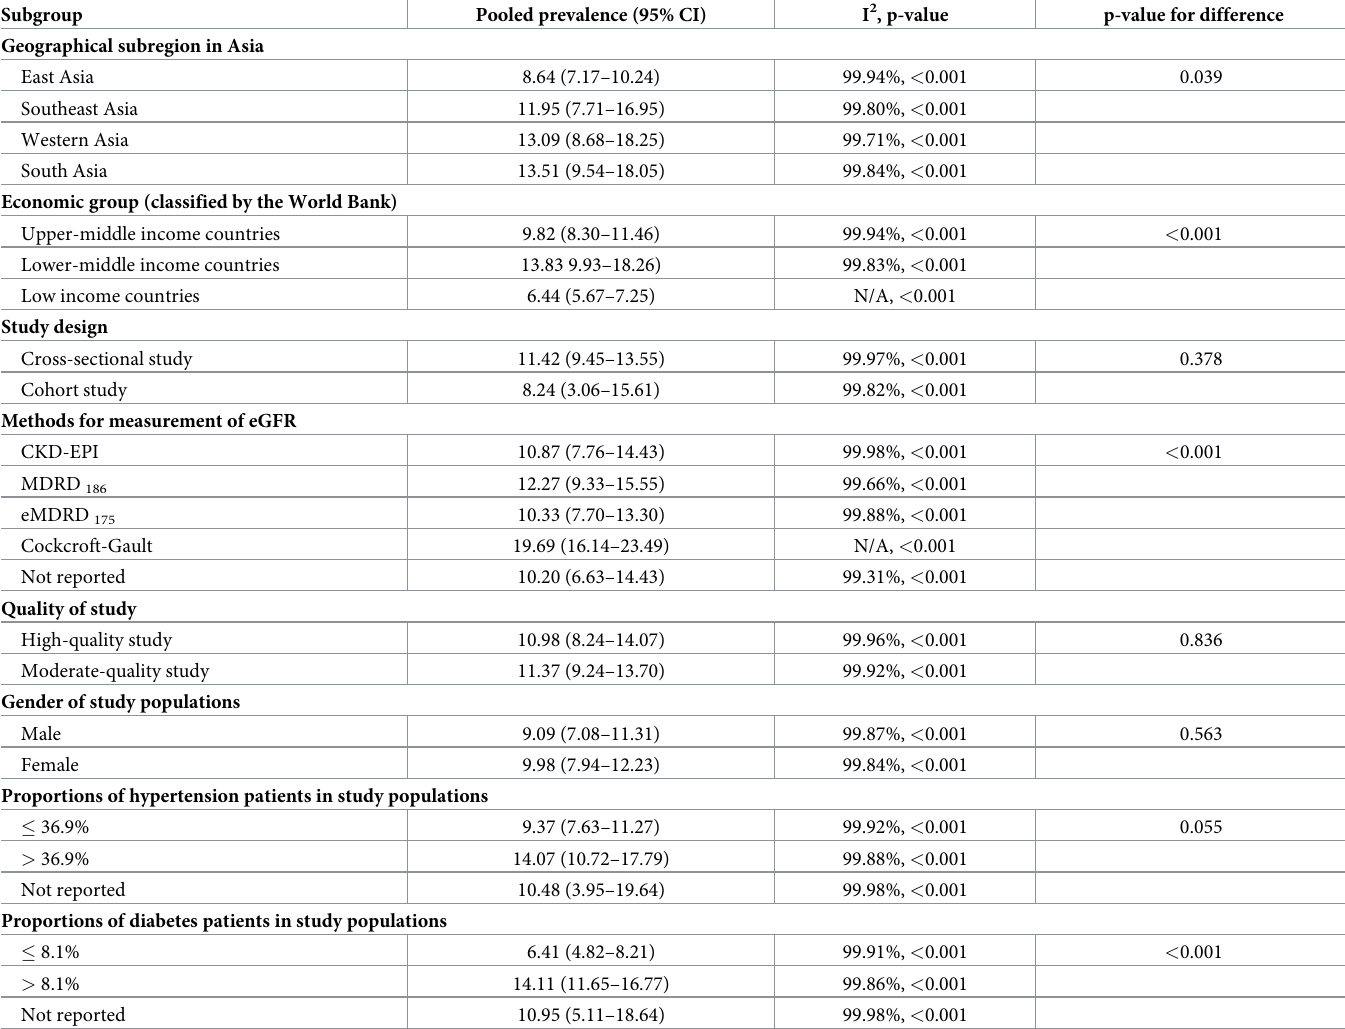
Table 4. Subgroup analysis of the pooled prevalence of CKD stage 3–5 in low- and middle-income countries in Asia. Subgroup Pooled prevalence (95%